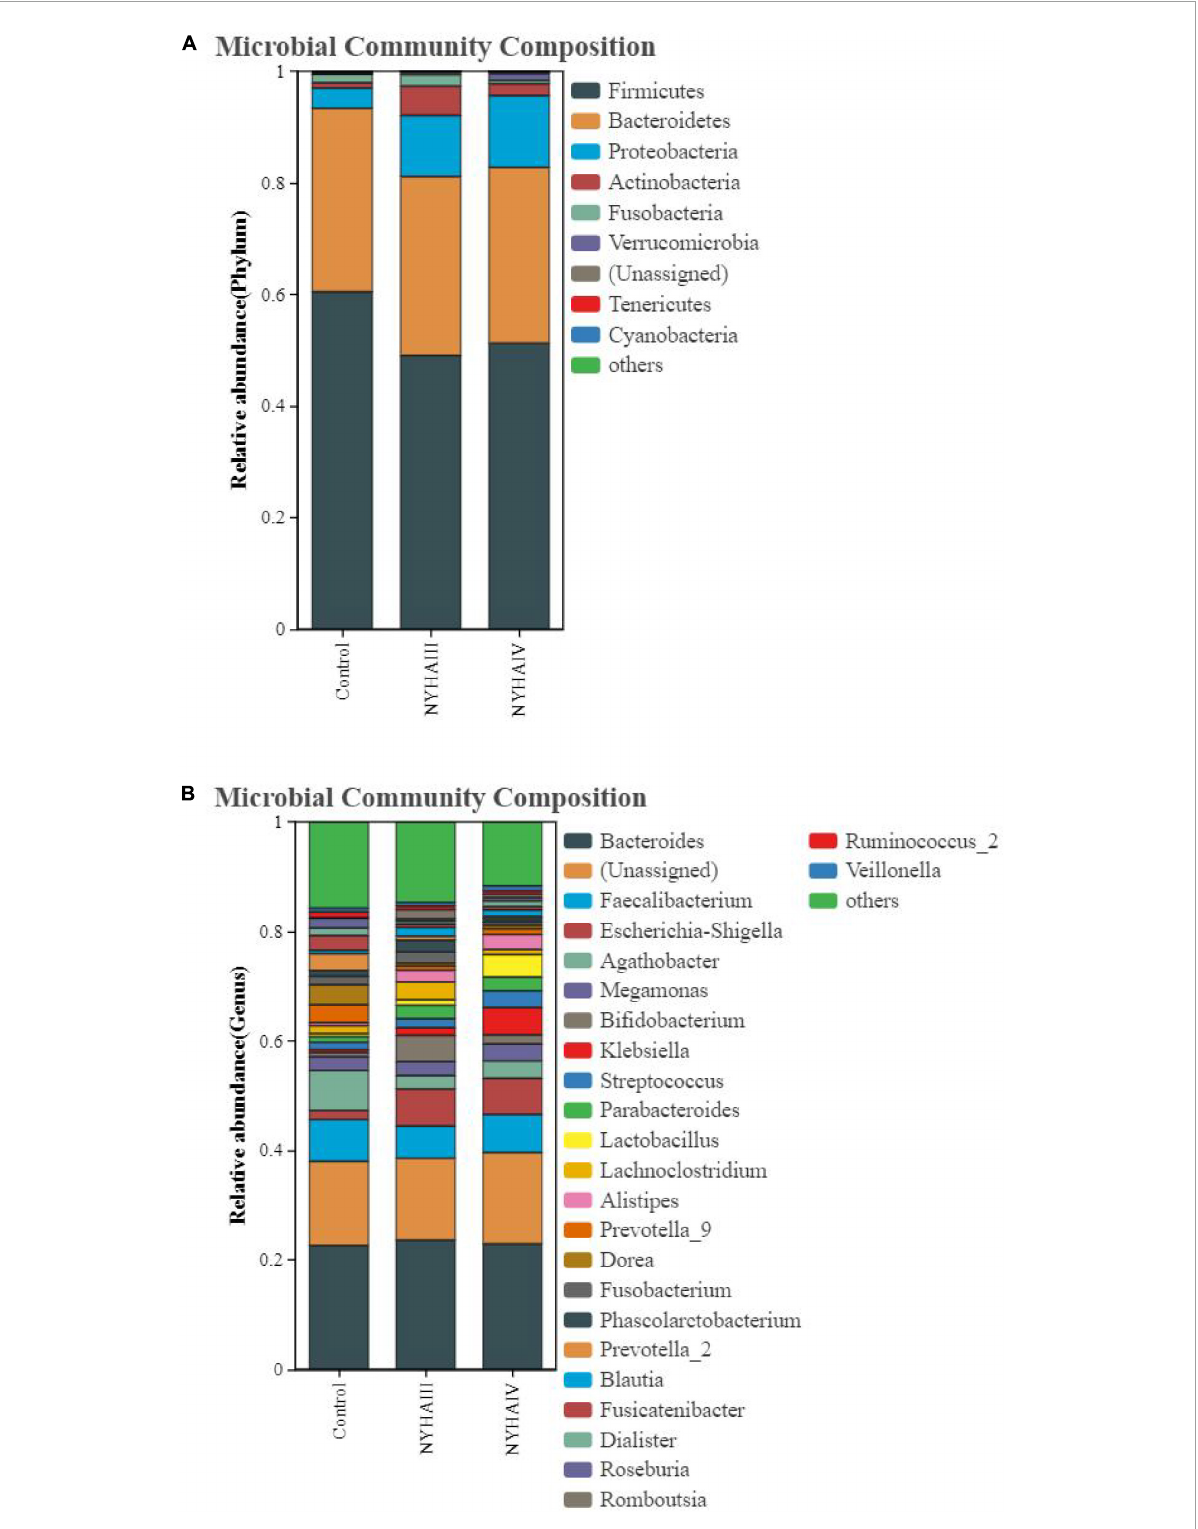
FIGURE4 The relative abundance distribution map of Control, New York Heart Association (NYHA) class III, and NYHA class IV of bacteria. (A) Phylum level. (B) Genus level.